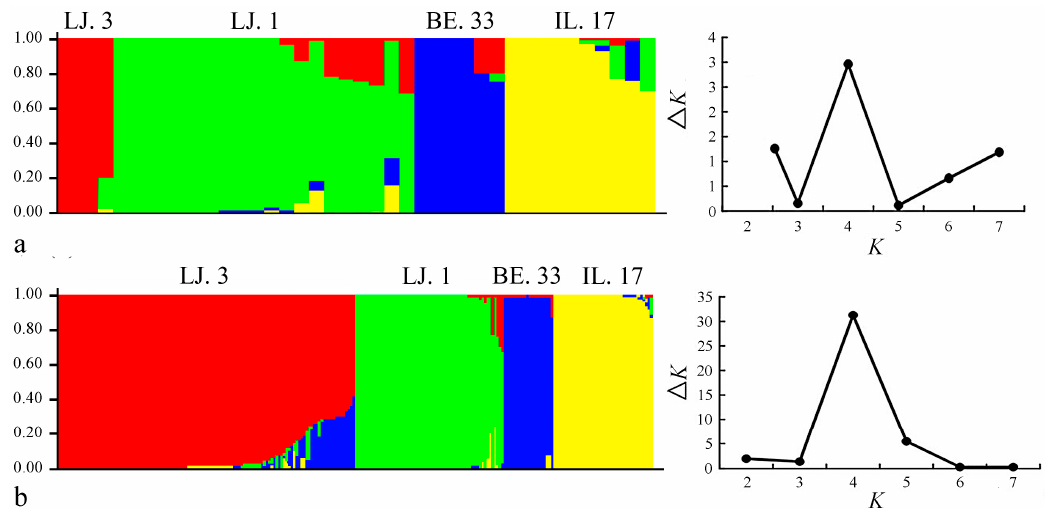
Figure 3. STRUCTURE analysis of the genetic structure of the four vetch accessions. The maximum delta K ( Δ K ) values were calculated to determine the topmost level of structure for K ranging from 2 to 8 (each with 10 independent runs). Here, K was four and four clusters. One color represented one cluster. The red: LJ. 3; The green: LJ. 1; The blue: BE. 33; The yellow: IL. 17. ( a ) The genetic structure of 10 individuals for each of the four accessions as inferred by STRUCTURE with the SCoT markers data set; ( b ) The genetic structure of 60 individuals for each of the four accessions as inferred by STRUCTURE with the SCoT markers data set.